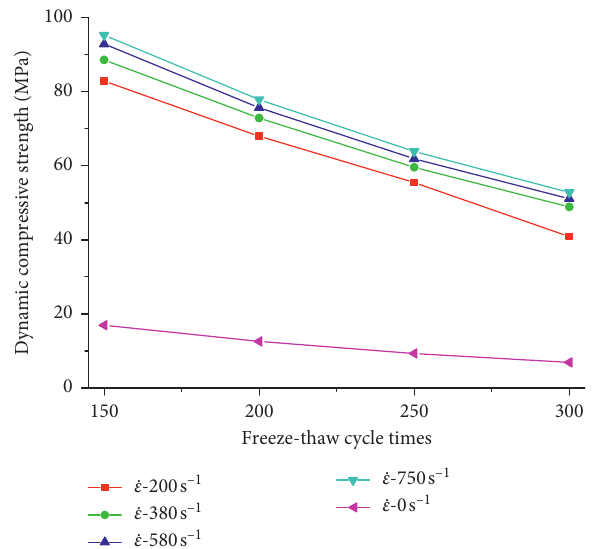
Figure 15: Influence of strain rate on dynamic compressive strength of rock mass under different freeze-thaw cycles.